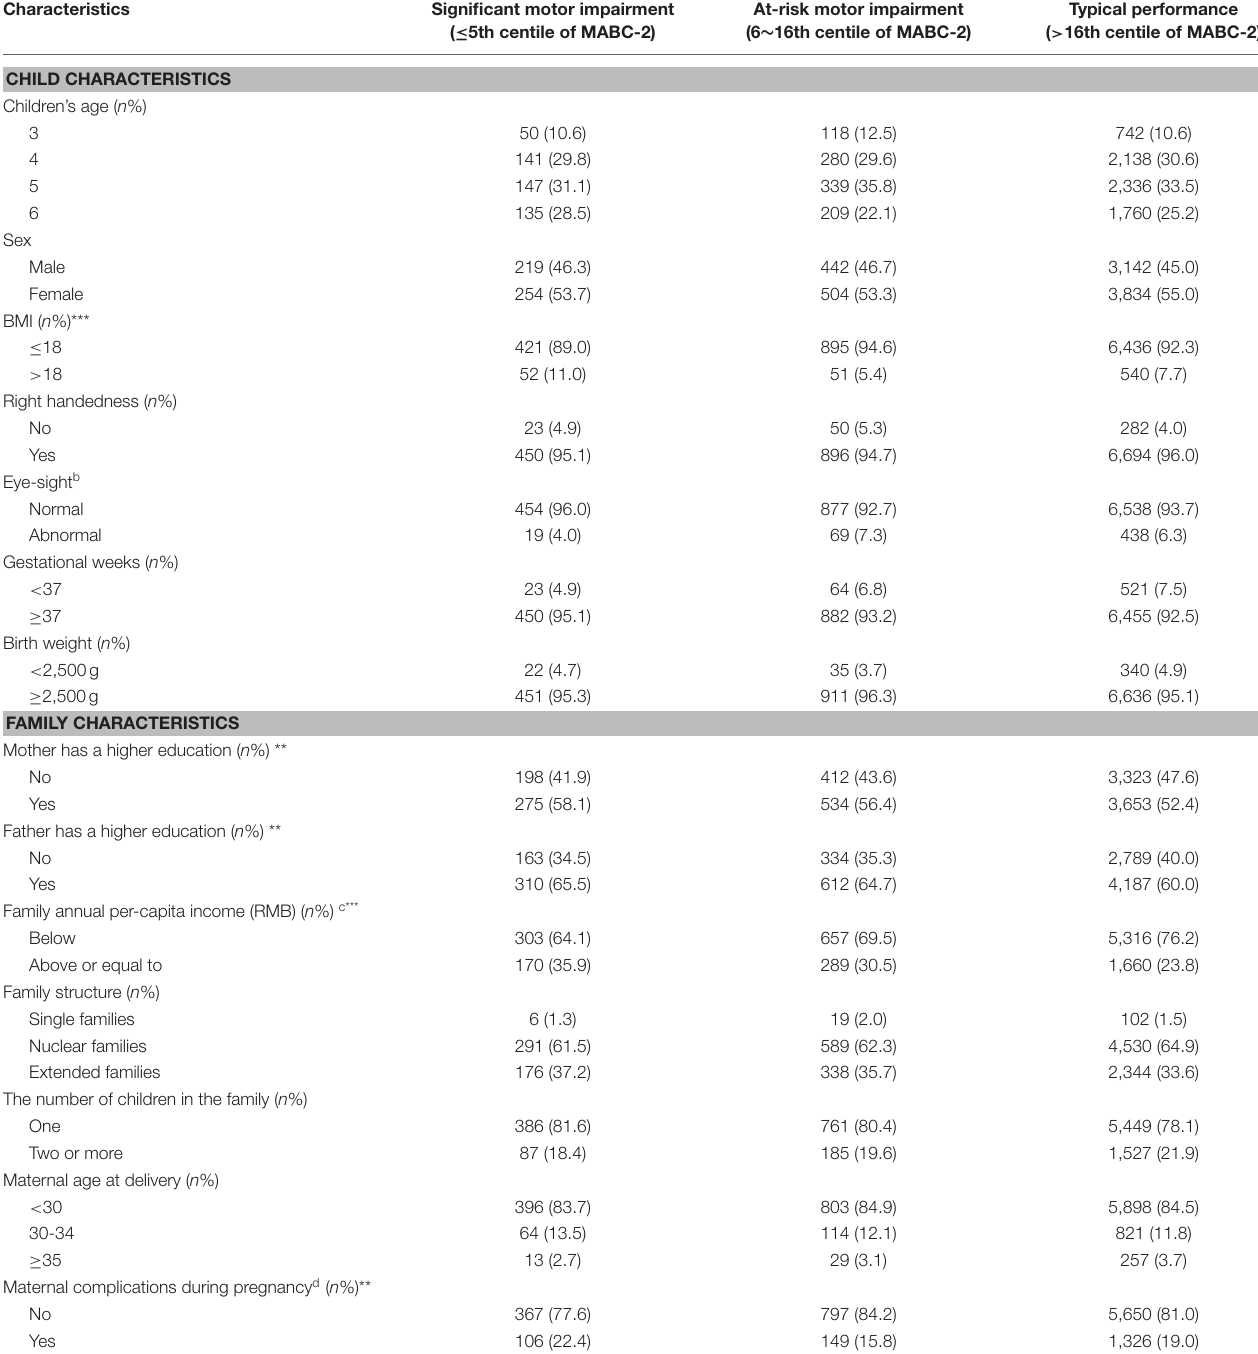
TABLE 1 | The children’s and family’s characteristics ( n = 8,395) a